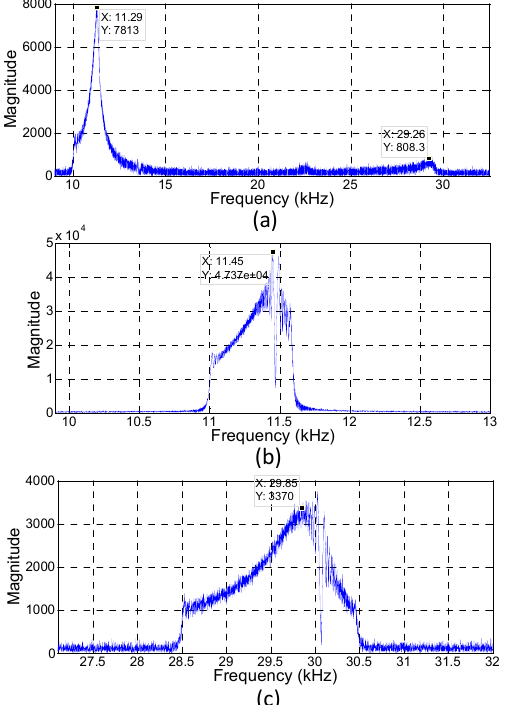
Figure 6. ( a ) The frequency response of the fabricated PMUT within 10 − 30 kHz to find the resonances. ( b , c ) Smaller sweeping ranges were used to locate the more accurate fundamental resonant frequency and fourth order resonance of the PMUT, respectively.